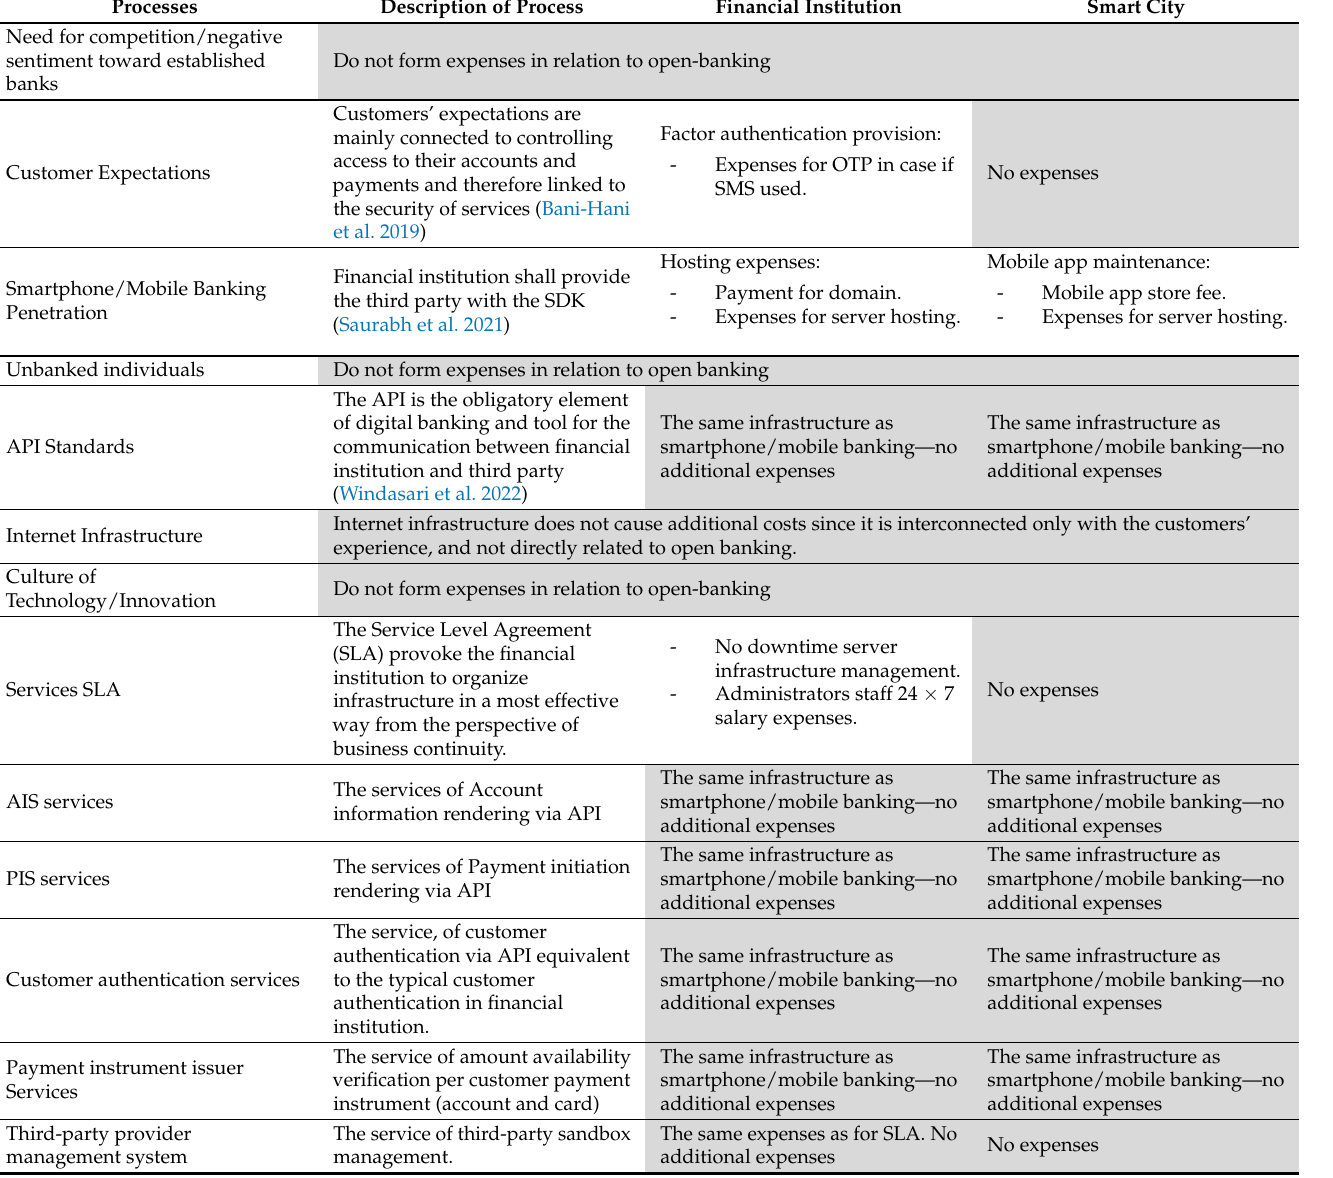
Table 3. Costs related to processes. Source: generated by the